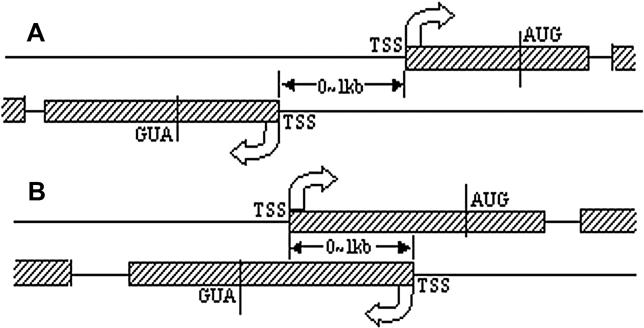
A Schematic Illustration of Head-to-Head Gene Organization(A and B) Nonoverlapping and overlapping head-to-head gene pairs, respectively.